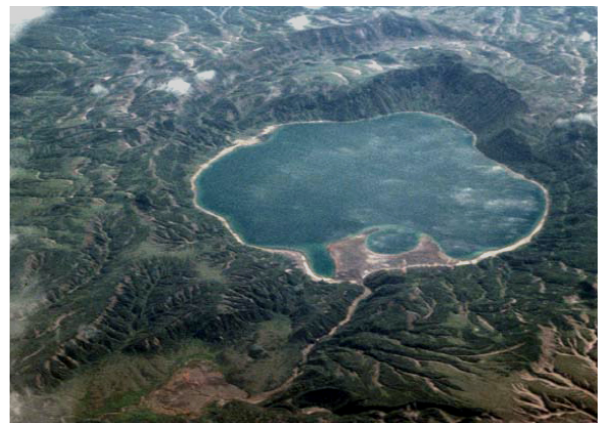
Fig. 1. Aerial photograph of Karymskoye caldera lake, taken from the North. The horse-shoe shaped structure in the northern part of the lake is a partly submerged crater formed by the 1996 eruption. Photograph by A. Belousov, September 1996.